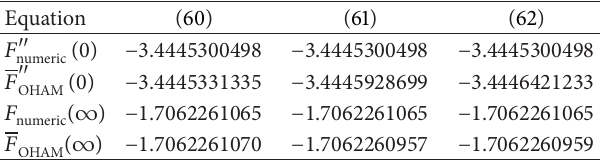
Table 10: Values of 𝐹 󸀠󸀠 (0) and 𝐹(∞) for 𝛽 = 0.5 , 𝑀 = 0.75 , and 𝑅 = −2